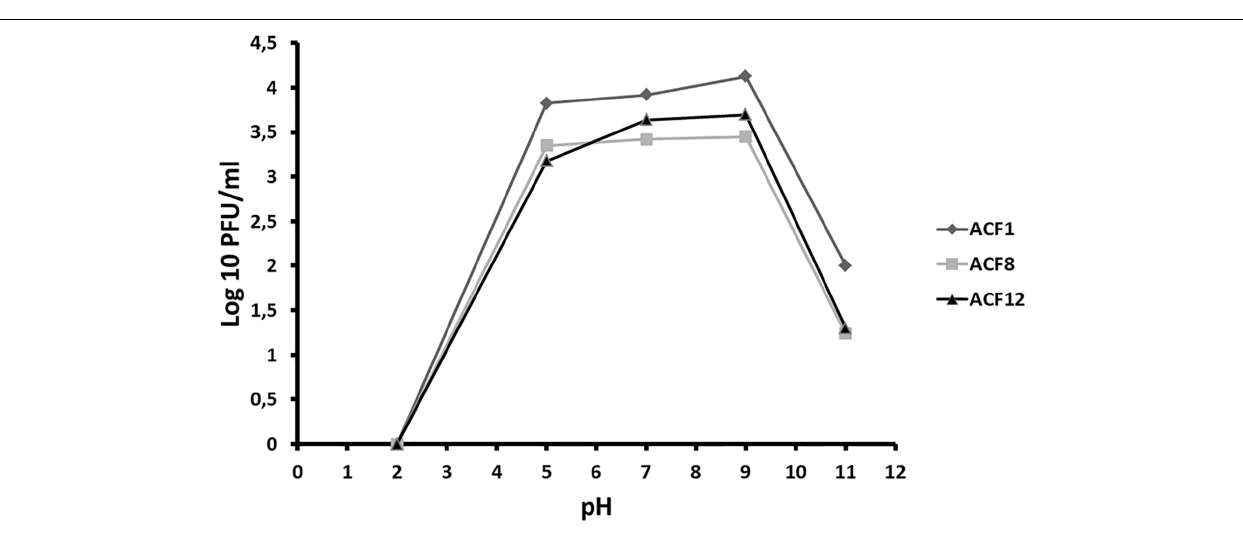
FIGURE 2 | The effect of pH on Acidovorax phage ACF1, ACF8, and ACF12